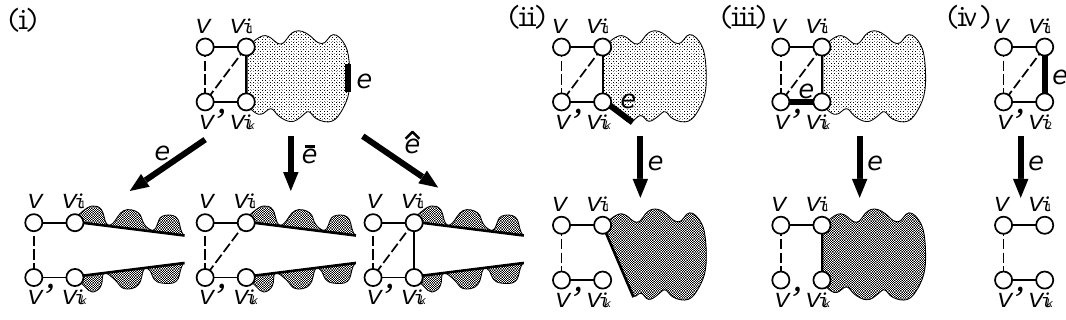
Figure 7. Types and subcases of blades, where two other subcases for (ii) and another } remains) for (iii) and (iv) are omitted. subcase ( i.e ., { v ′ ; v i 1